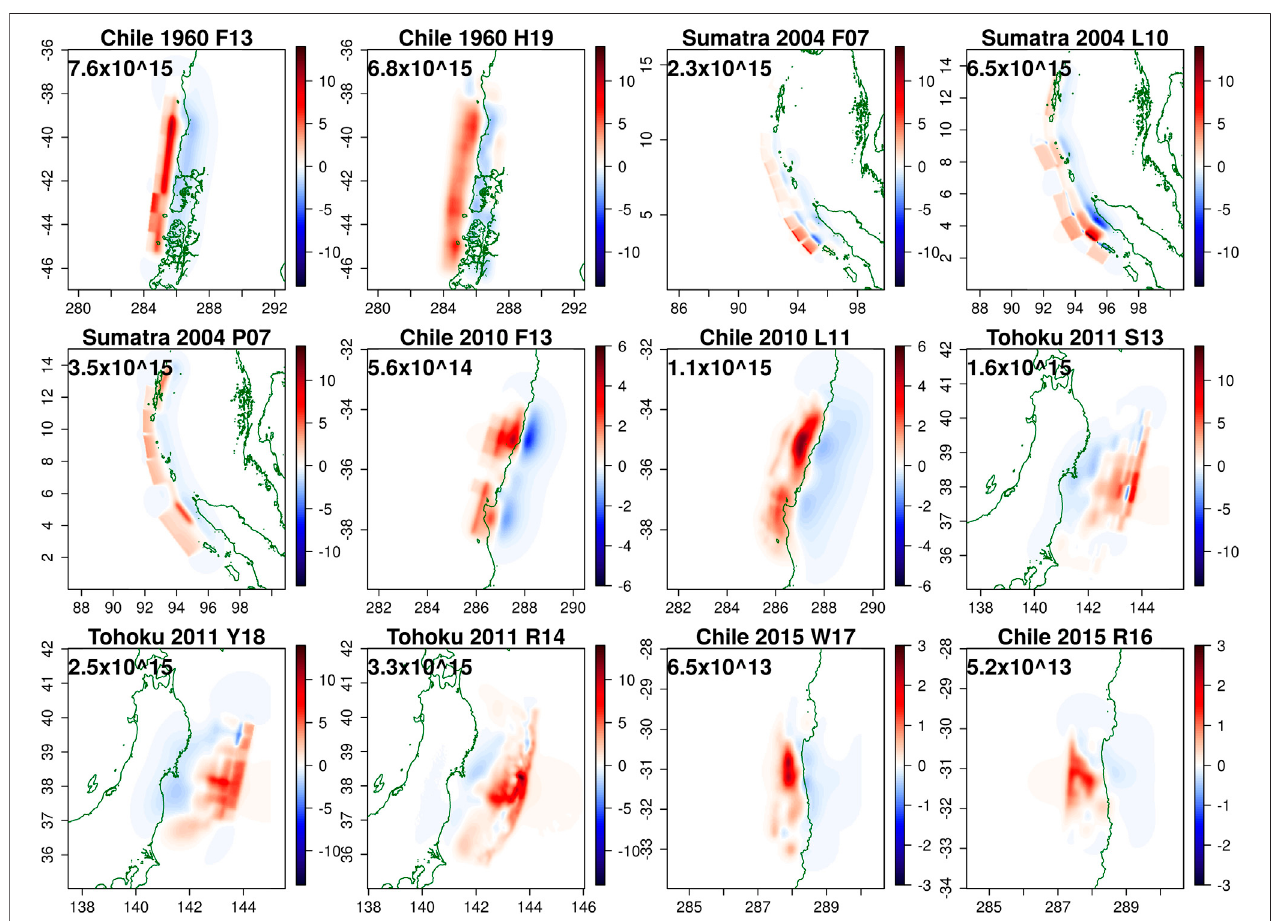
FIGURE 2 | The vertical co-seismic displacement for all source models. Text beneath the title gives the initial available potential energy of the ocean surface displacement (kg m 2 /s 2 , derived by integrating Eq. 5 in space; there is no contribution from deformation on land). The sources are based on fi nite-fault inversions in the following publications: F13 (Fujii and Satake, 2013); H19 (Ho et al., 2019); F07 (Fujii and Satake, 2007); L10 (Lorito et al., 2010); P07 (Piatanesi and Lorito, 2007); L11 (Lorito et al., 2011); S13 (Satake et al., 2013); Y18 (Yamazaki et al., 2018); R14 (Romano et al., 2014); W17 (Williamson et al., 2017); R16 (Romano et al., 2016).